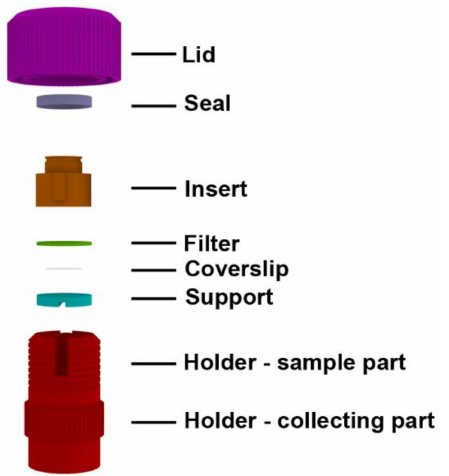
Figure 1. The schema of the developed device in the arrangement for dry